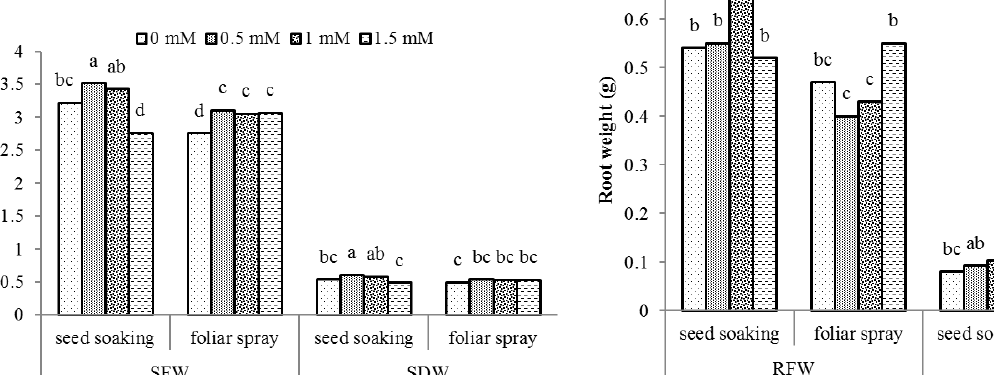
Fig. 1. Effect of SA and its application method on shoot fresh weight (SFW) and shoot dry weight (SDW) of watermelon seedling subjected to chilling stress. Values followed by different letters were significant difference according to Duncan’s Mul- tiple Range Test at p < 0.05